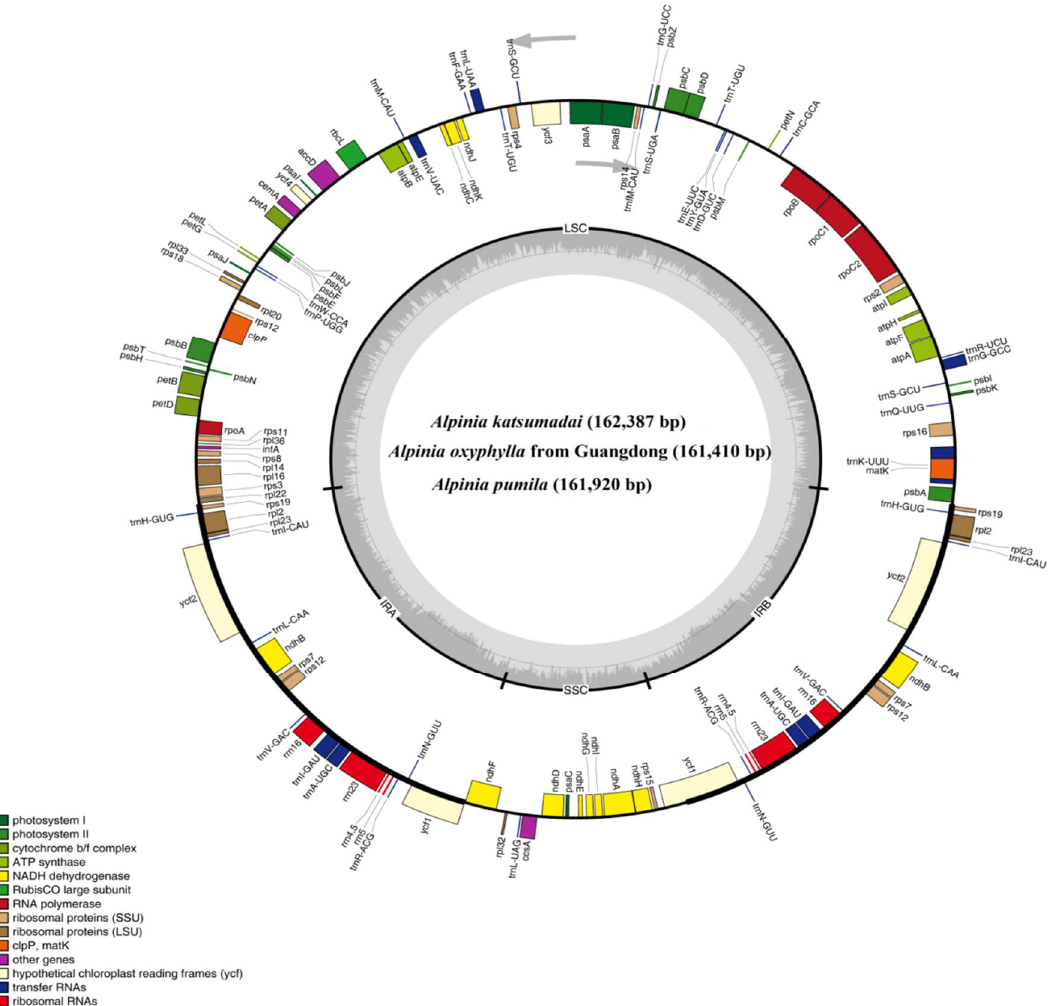
Figure 1. Circular gene map of chloroplast genomes of three Alpinia species. The gray arrowheads indicate the direction of the genes. Genes shown inside the circle are transcribed clockwise and those outside are transcribed counterclockwise. Different genes are color coded. The innermost darker gray corresponds to GC content, whereas the lighter gray corresponds to AT content. IR, inverted repeat; LSC, large single copy region; SSC, small single copy region. Table 1. Comparison of the general features of the five Alpinia chloroplast genomes.